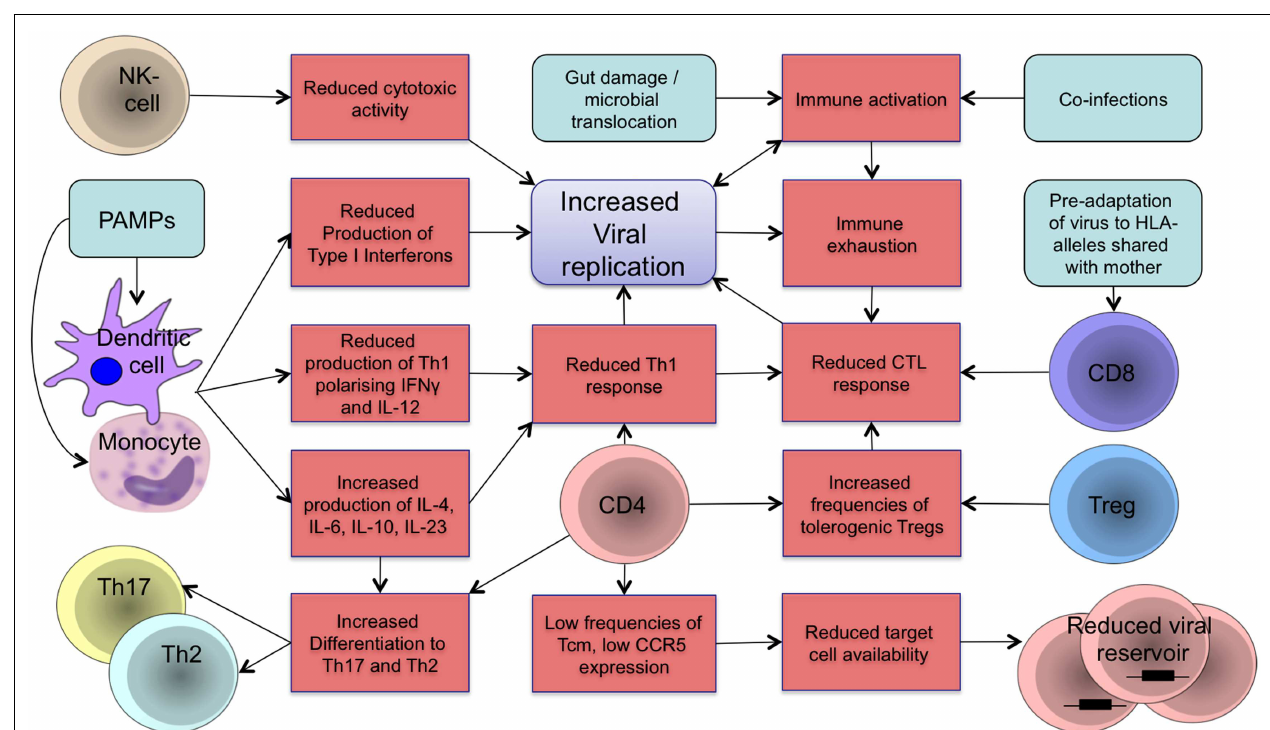
immune activation and immune exhaustion that lead to immune dysfunction and loss of immune control resulting in further viral replication in a positive feedback loop. Differences in target cell availability and memory differentiation in early life affect the size and composition of the viral reservoir in children. Main aspects of the developing immune system in regards to vertical HIV infection are summarized.Treg: regulatoryT-cells; NK cell: natural killer cell; PAMPs: pathogen-associated molecular patterns; CTL: